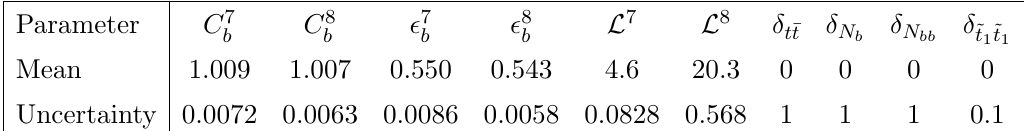
7 ; 8 and their , (cid:15) 7 ; 8 , and b b L has units of fb (cid:0) 1 L